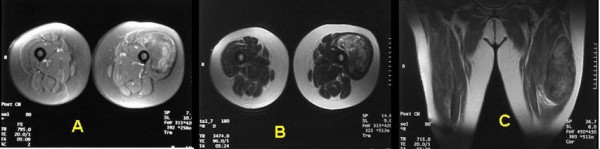
Magnetic tomography imaging (A) axial T1-weighted, (B) T2-weigthed, and (C) coronal T1-weighted views show a well-circumscribed heterogeneous soft tissue mass within the left vastus lateralis muscle.